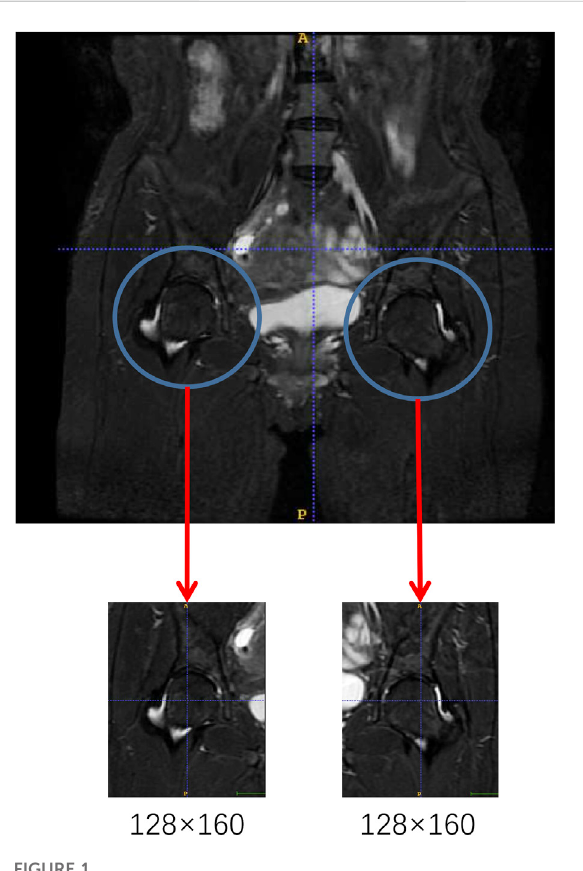
FIGURE 1 Image preprocessing